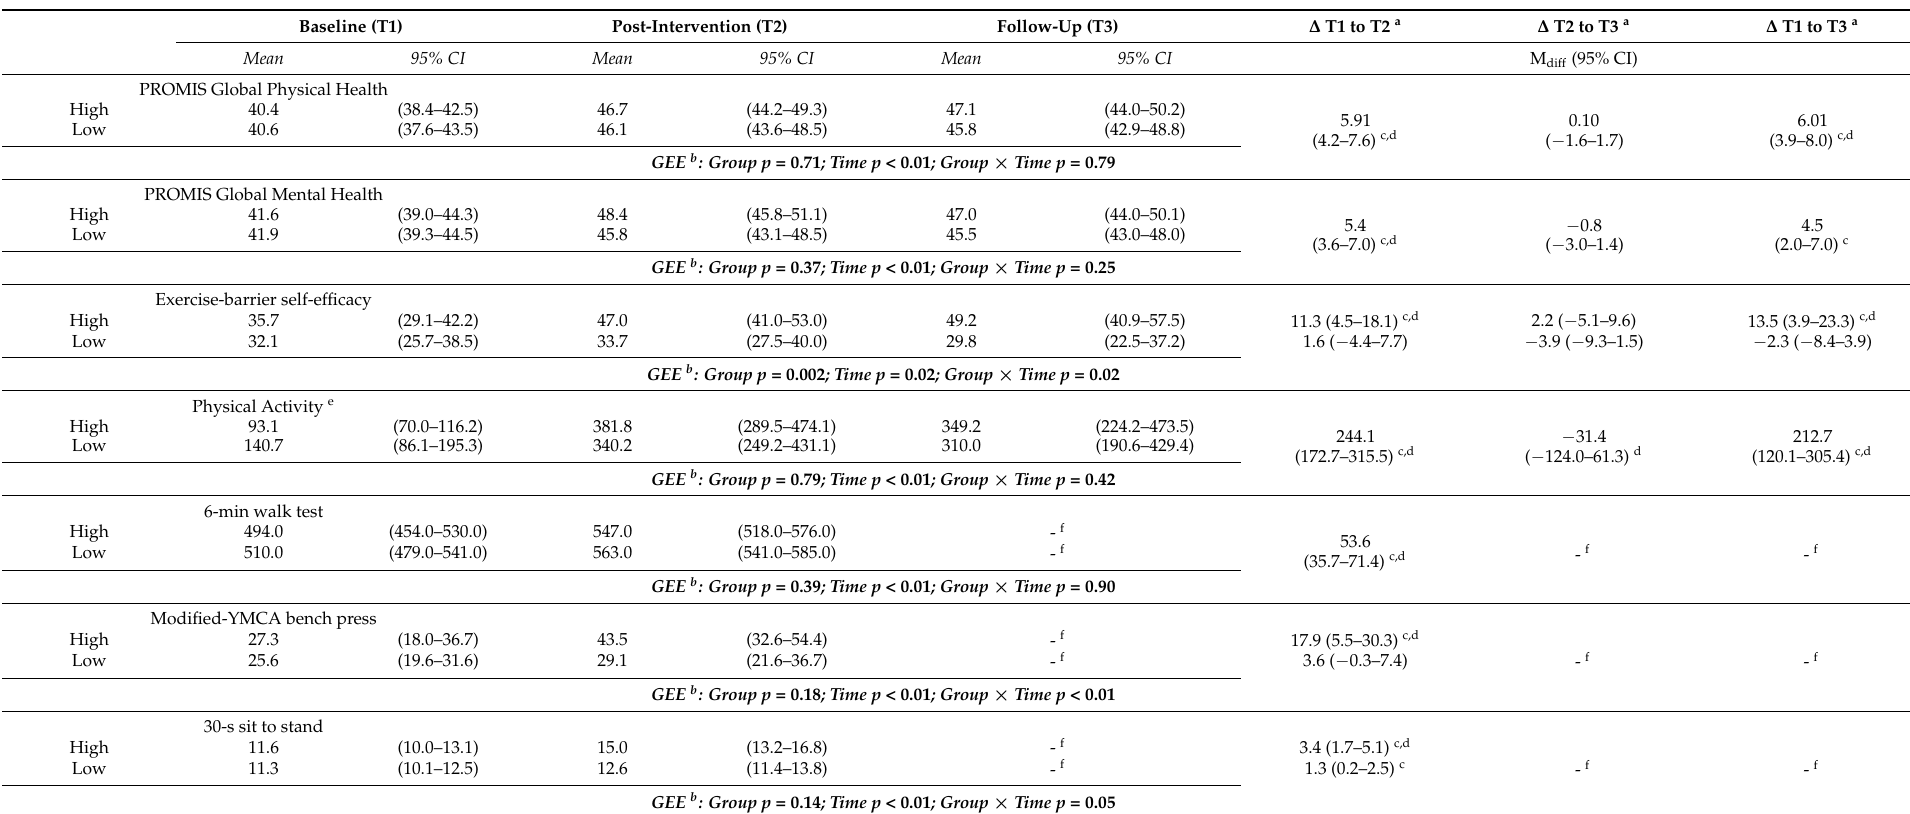
Table 5. Efficacy of exercise: Mean and 95% confidence intervals of health outcomes at baseline, post-intervention and follow-up